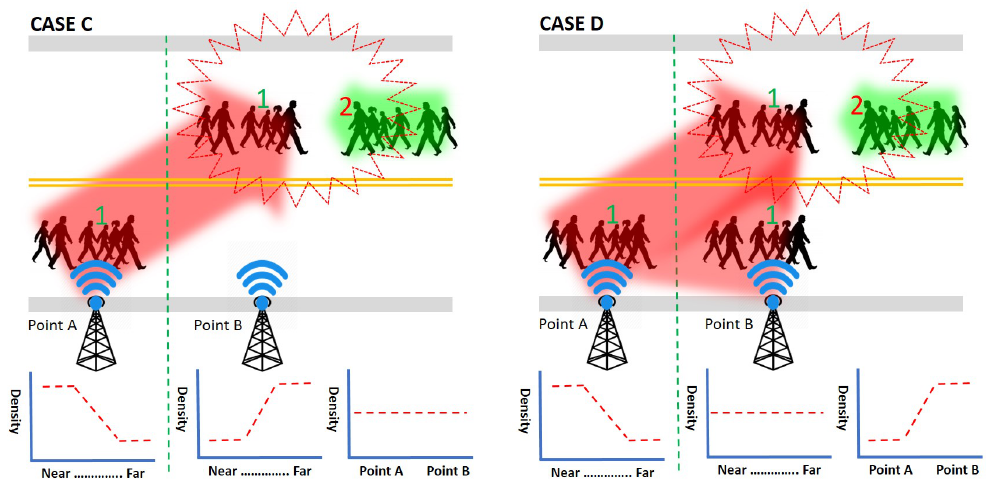
Figure 10. Wrong lane group detection via